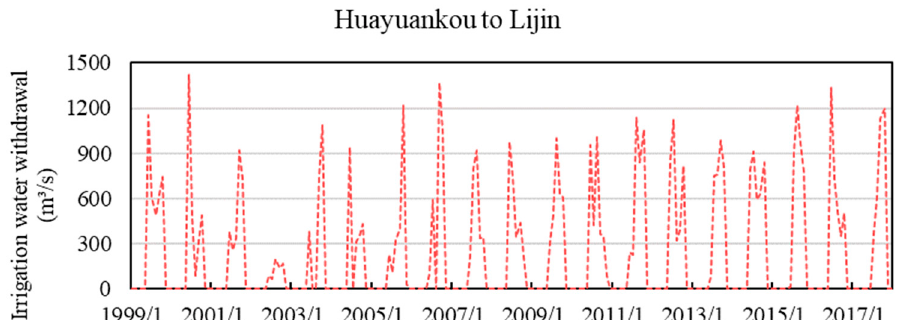
Figure 9. Monthly irrigation withdrawal from Huayuankou to Lijin station.